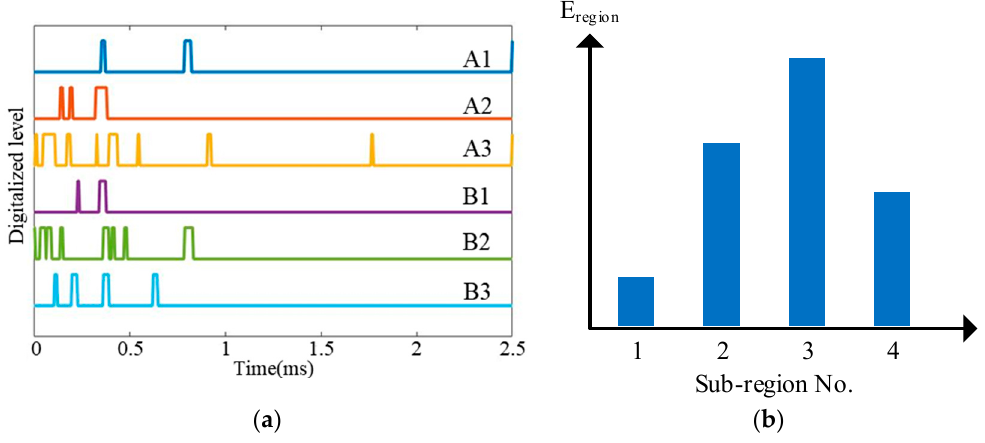
Figure 14. Impact region localization results based on the CSSN and CPSN: ( a ) CDSs and ( b ) E region of sub-regions.